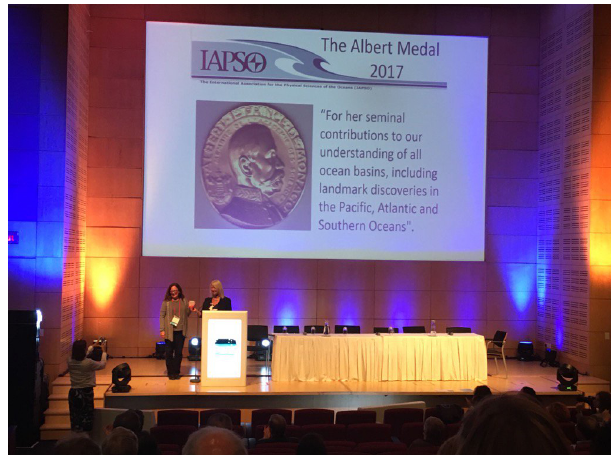
Figure 10. Presentation of the 2017 Prince Albert I Medal to Pro- fessor Lynne Talley (source: IAPSO archives).